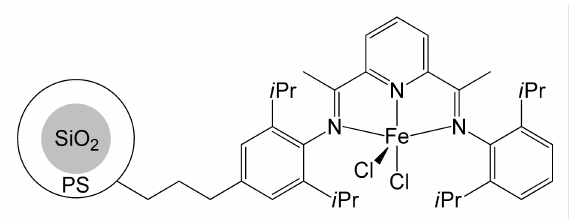
Figure 6. Immobilization of iron pre-catalyst performed by Jin and Liu through copolymerization with polystyrene (PS)